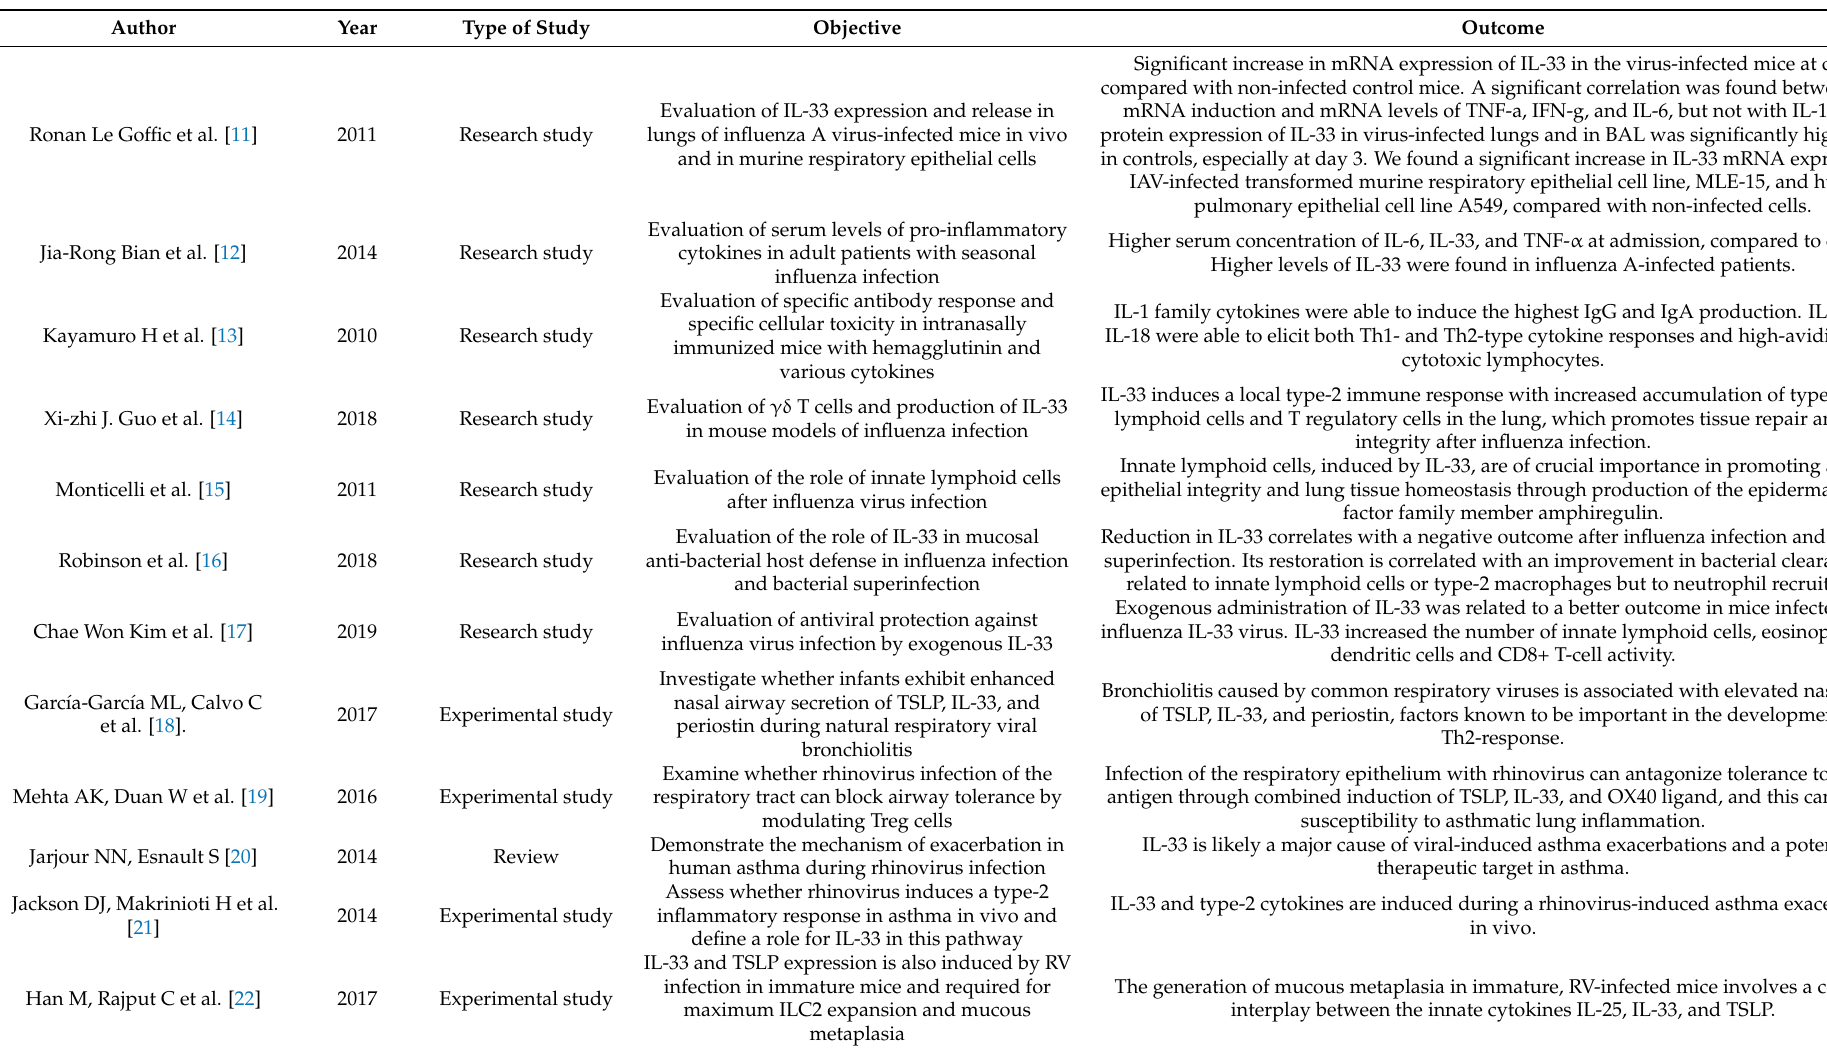
Table 1. Research articles analyzed and their main